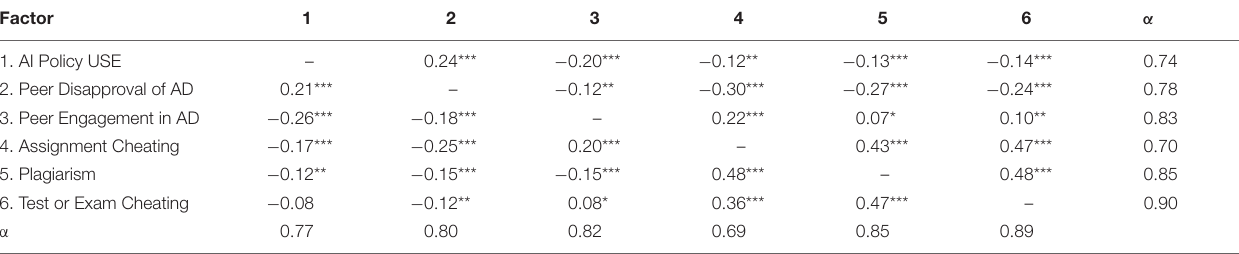
TABLE 5 | Intercorrelations among the six latent factors and Cronbach’s alphas by cohort. Factor